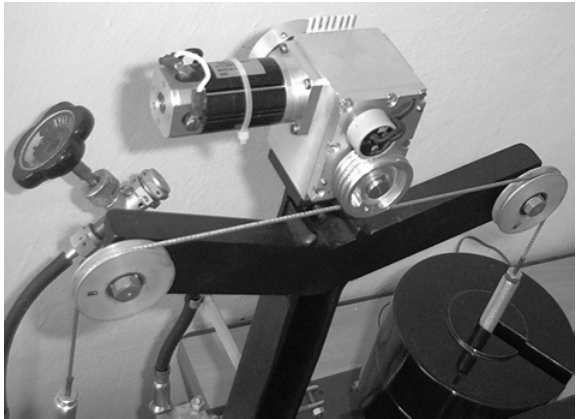
Fig 8. Actuator under loading